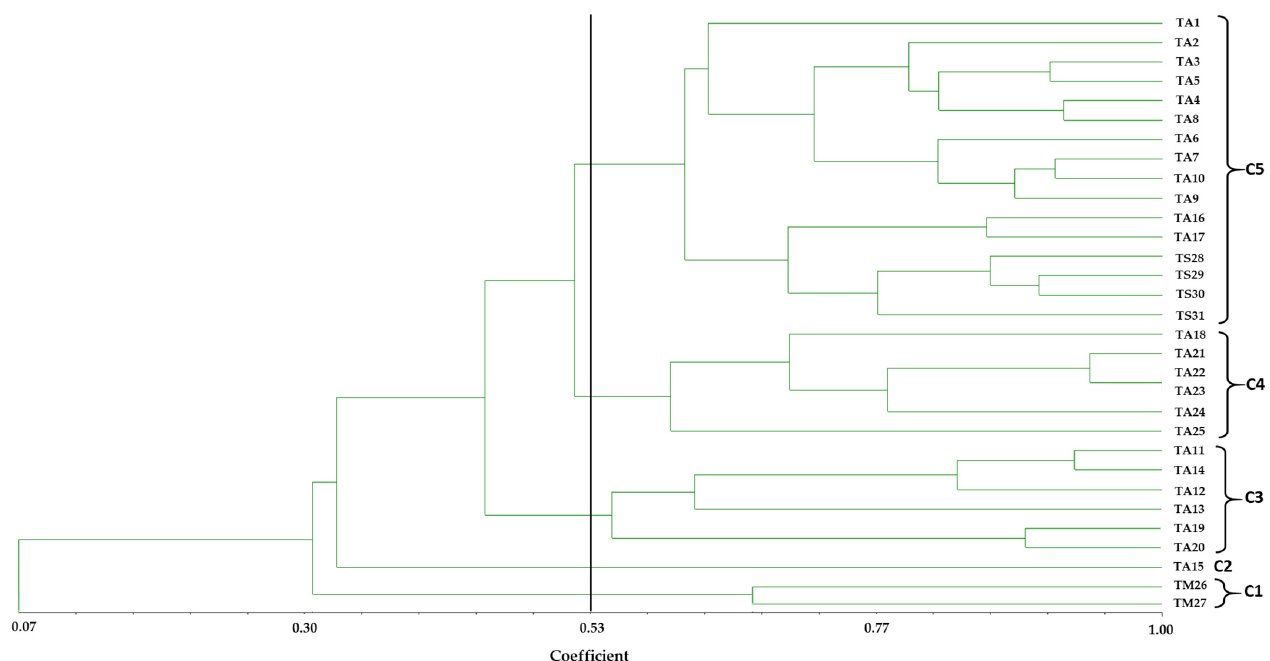
Figure 3. Dendrogram showing the genetic similarity among the 31 genotypes of Triticum , obtained by the UPGMA method and Jaccard coefficient, forming 5 clusters. Cut-off point of approximately 50% (dotted line).